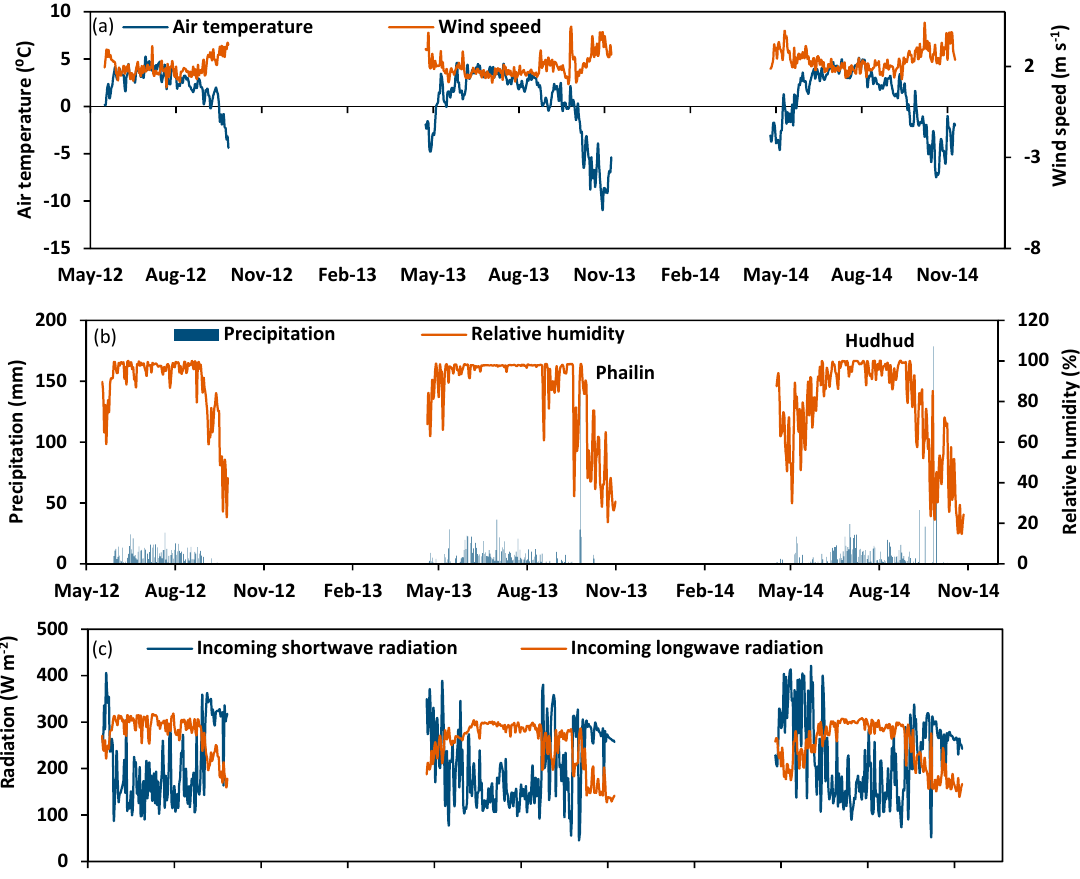
Figure 2. Daily mean values of ( a ) air temperature and wind speed, ( b ) precipitation and relative humidity and ( c ) Incoming shortwave radiation and incoming longwave radiation during 5